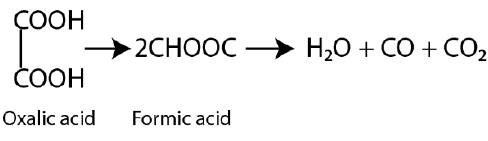
Figure 2. Dehydration of oxalic acid molecule.